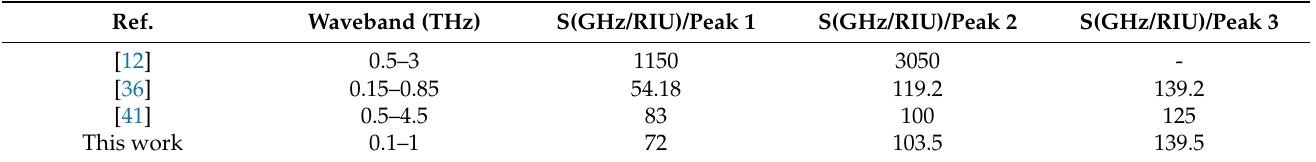
Table 2. Sensitivity comparison results of various THz